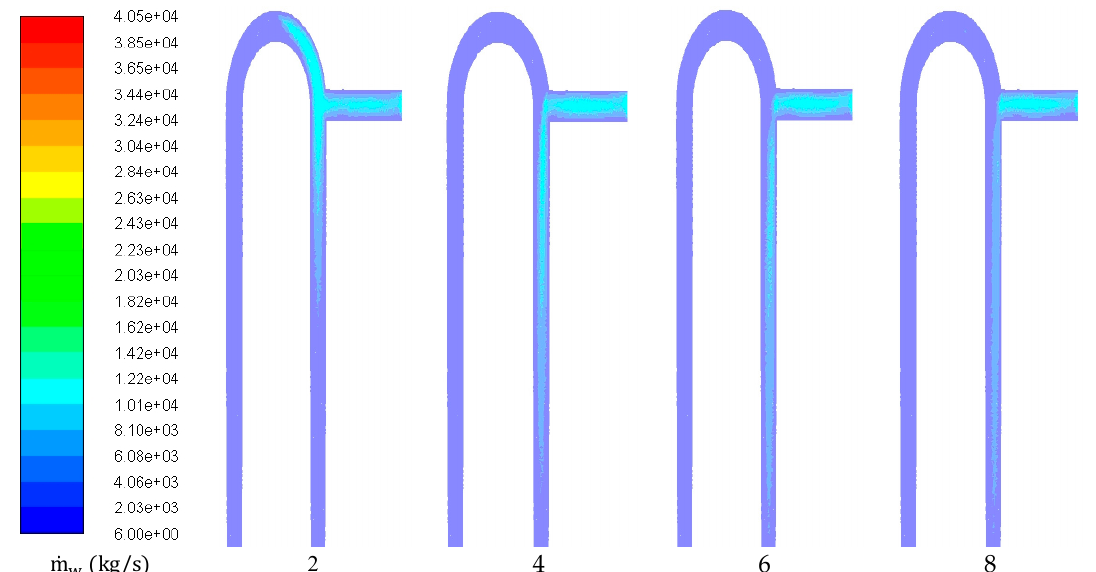
Figure 25. Turbulent Reynolds number contours at di ff erent flow ratios and X w = 6187.64, α m = 0.2 and X v = 0.5.